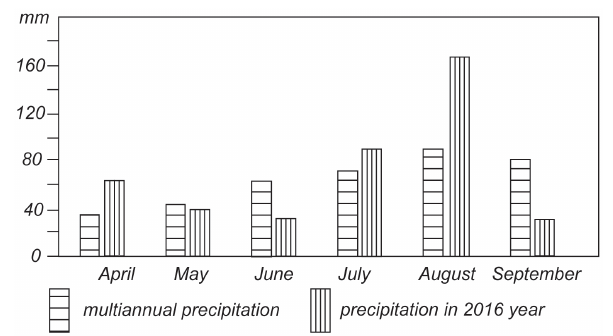
Figure 7. Comparison of multiannual and annual (2016 year) sum- mer precipitation (from Nida meteorological